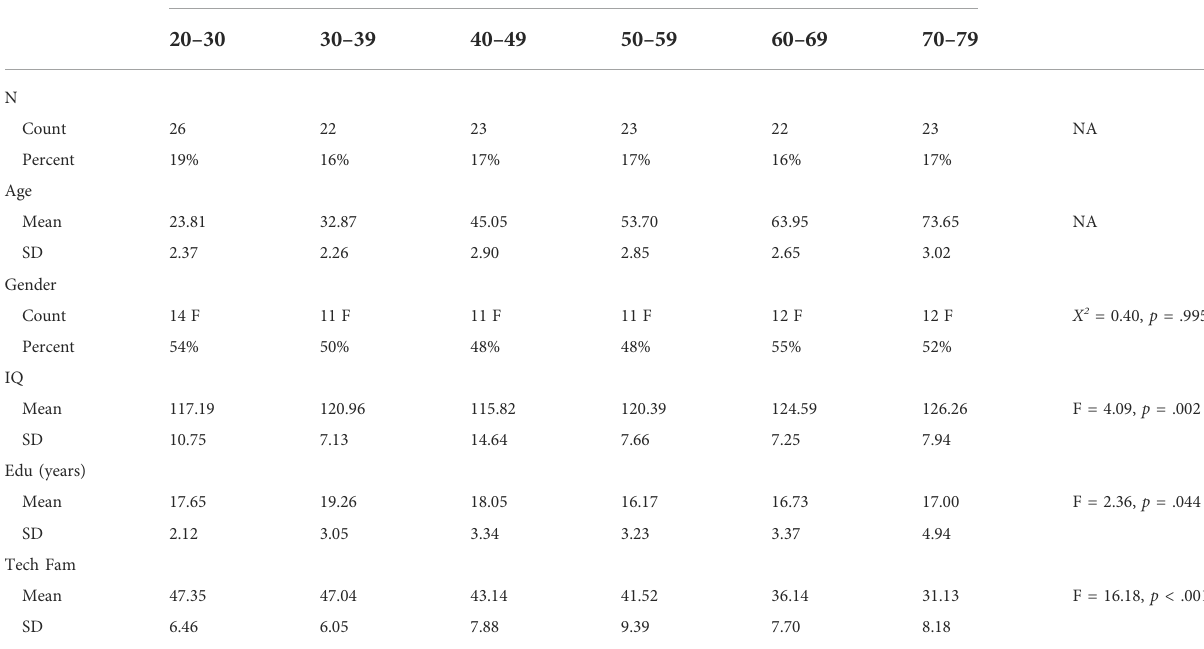
TABLE 1 Study 1 demographic